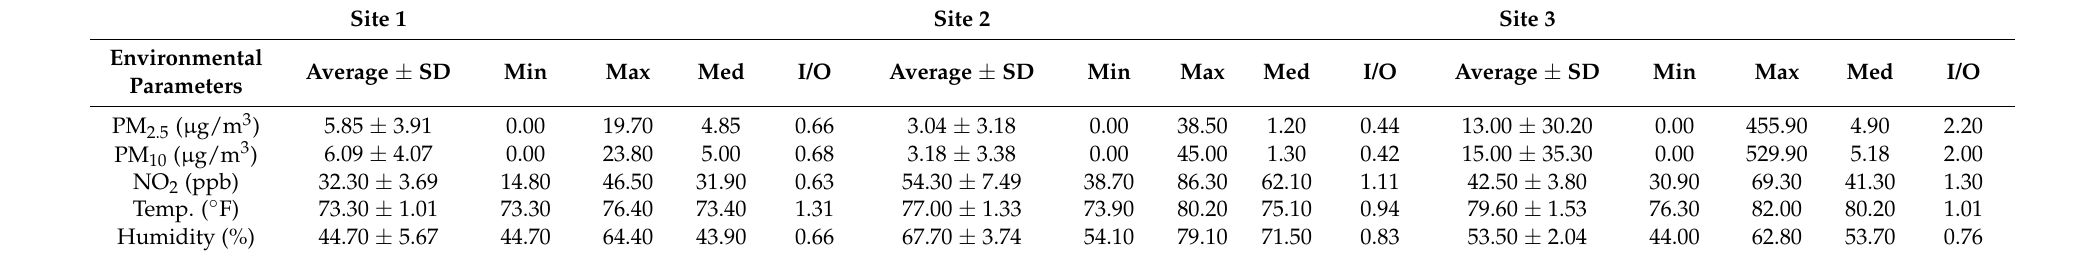
Table 3. Descriptive statistics of indoor environmental parameters measured at sites 1, 2, and 3.